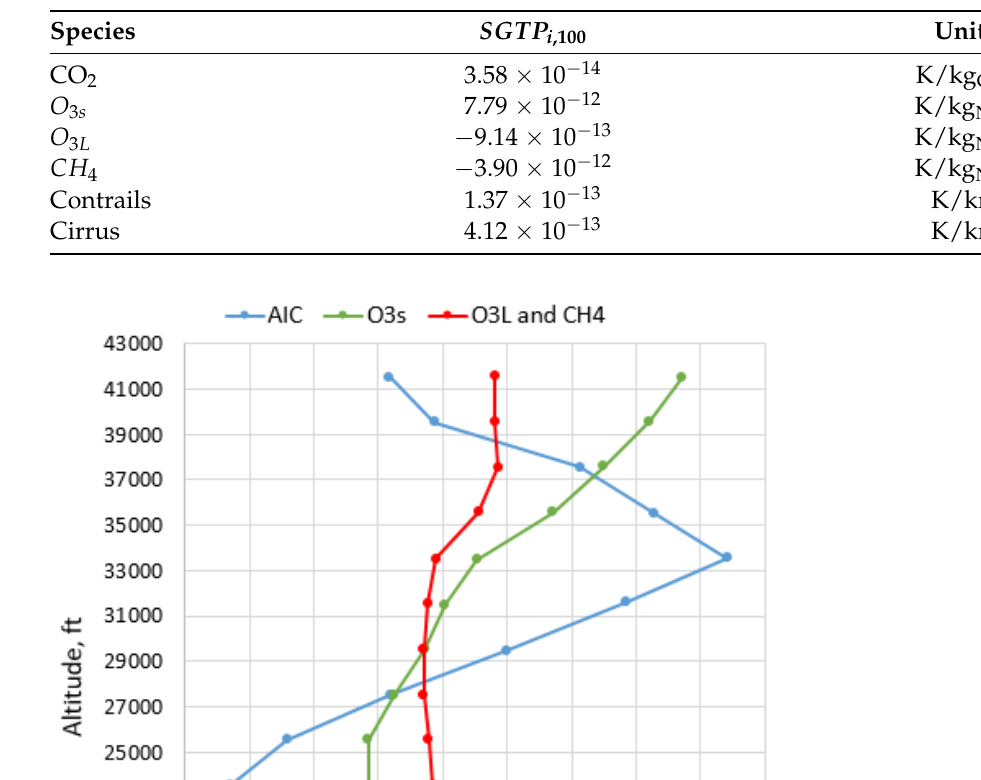
Table 4. SGTP values [60].